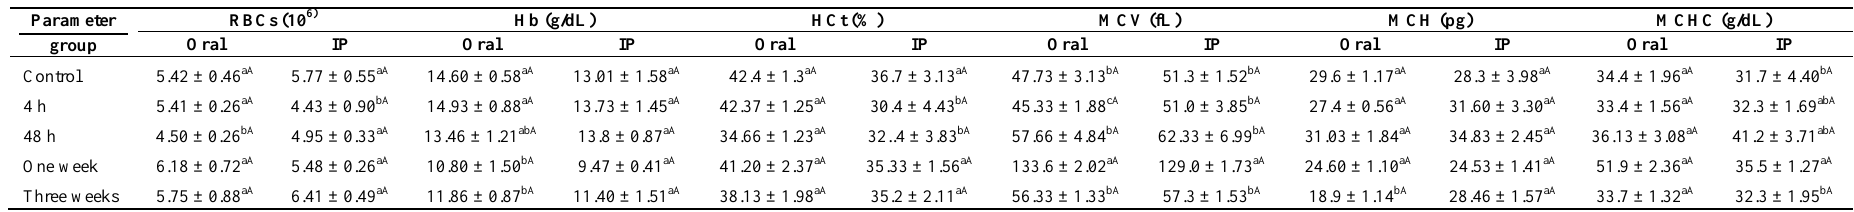
Table 2. The effect of oral administration and i.p. injection of ENPs on red blood cells (RBCs) and hematological parameters in rats. Hct, hematocrite; MCV, mean corpuscular volume; MCH, mean corpuscular hemoglobin; MCHC, mean corpuscular hemoglobin concentration. Parameter group